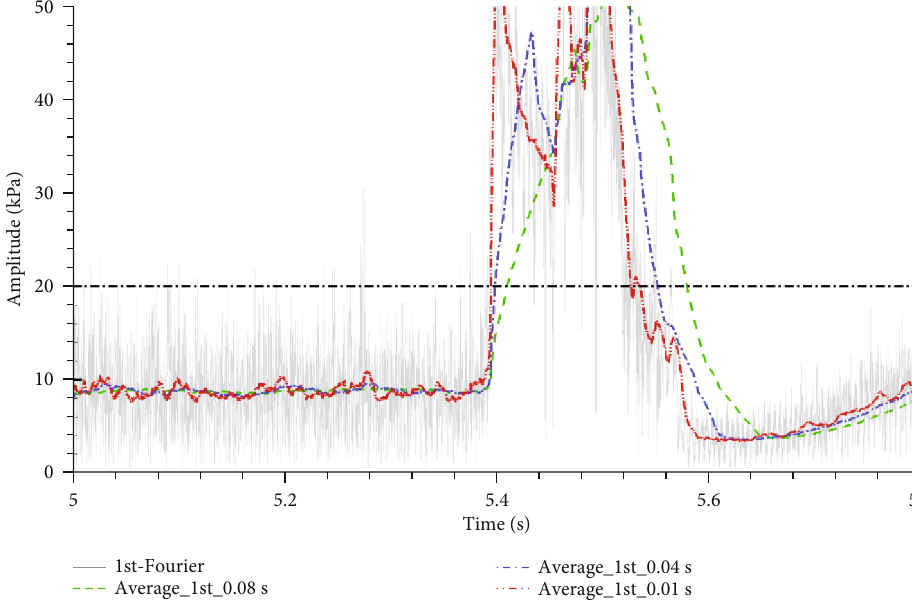
Figure 15: First-order harmonic analysis results of the inlet static pressure during the instability process of the compressor.